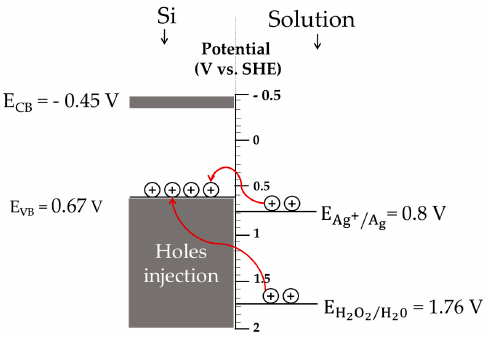
Figure 1. Schematic of the potential relationship between bands in a silicon (Si) substrate, Ag + /Ag, and H 2 O 2 /H 2 O redox pairs.